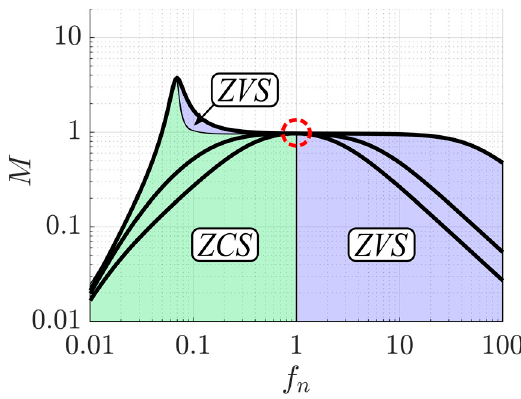
Figure 13. Zero voltage switching (ZVS) regions of the LLC converter.